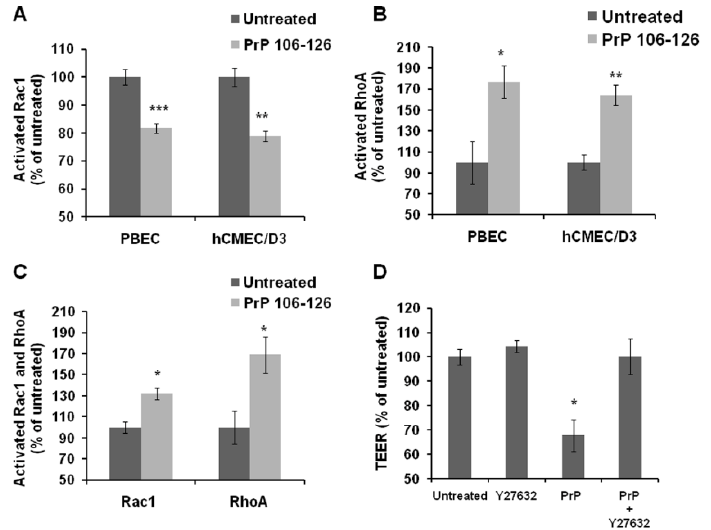
Figure 3. Involvement of small GTPases in PrP-induced damage to the BBB. ( A ) Rac1 in PBEC and in hCMEC/D3 was inactivated after 2 h exposure to 100 µM PrP 106-126. Activation of Rac1 was measured by using G-Lisa colorimetric assay ( n = 3 for each cell type). ( B ) RhoA in PBEC and in hCMEC/D3 was activated after 2 h exposure to 100 µM PrP 106-126. Activation of RhoA was measured by using G-Lisa assay ( n = 3 for each cell type). ( C ) RhoA was still activated after 24 h exposure to 100 µM PrP 106-126 in PBEC while Rac1 changed its activation mode from inhibition ( A ) to activation ( n = 3 for each cell type). ( D ) Inhibition of Rho kinase by 50 µM Y27632 together with 100 µM PrP 106-126 prevented the decrease in TEER observed when treating only with PrP 106-126 for 24 h in an in-vitro BBB model ( n = 3 – 5 Transwell inserts). Results are expressed as the mean ± SEM. * p < 0.05, ** p < 0.01, *** p < 0.001 compared with untreated. PrP; PrP 106-126.